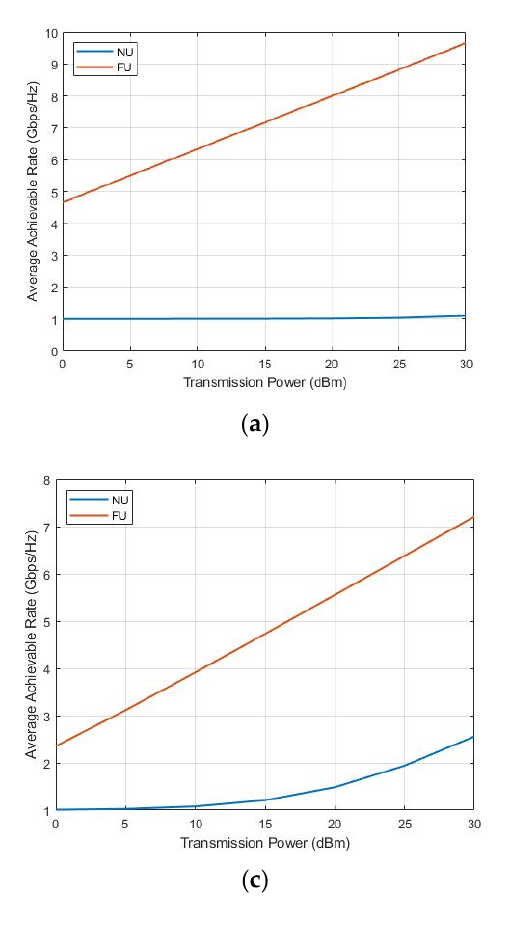
Figure 6. Average rate versus transmission power.